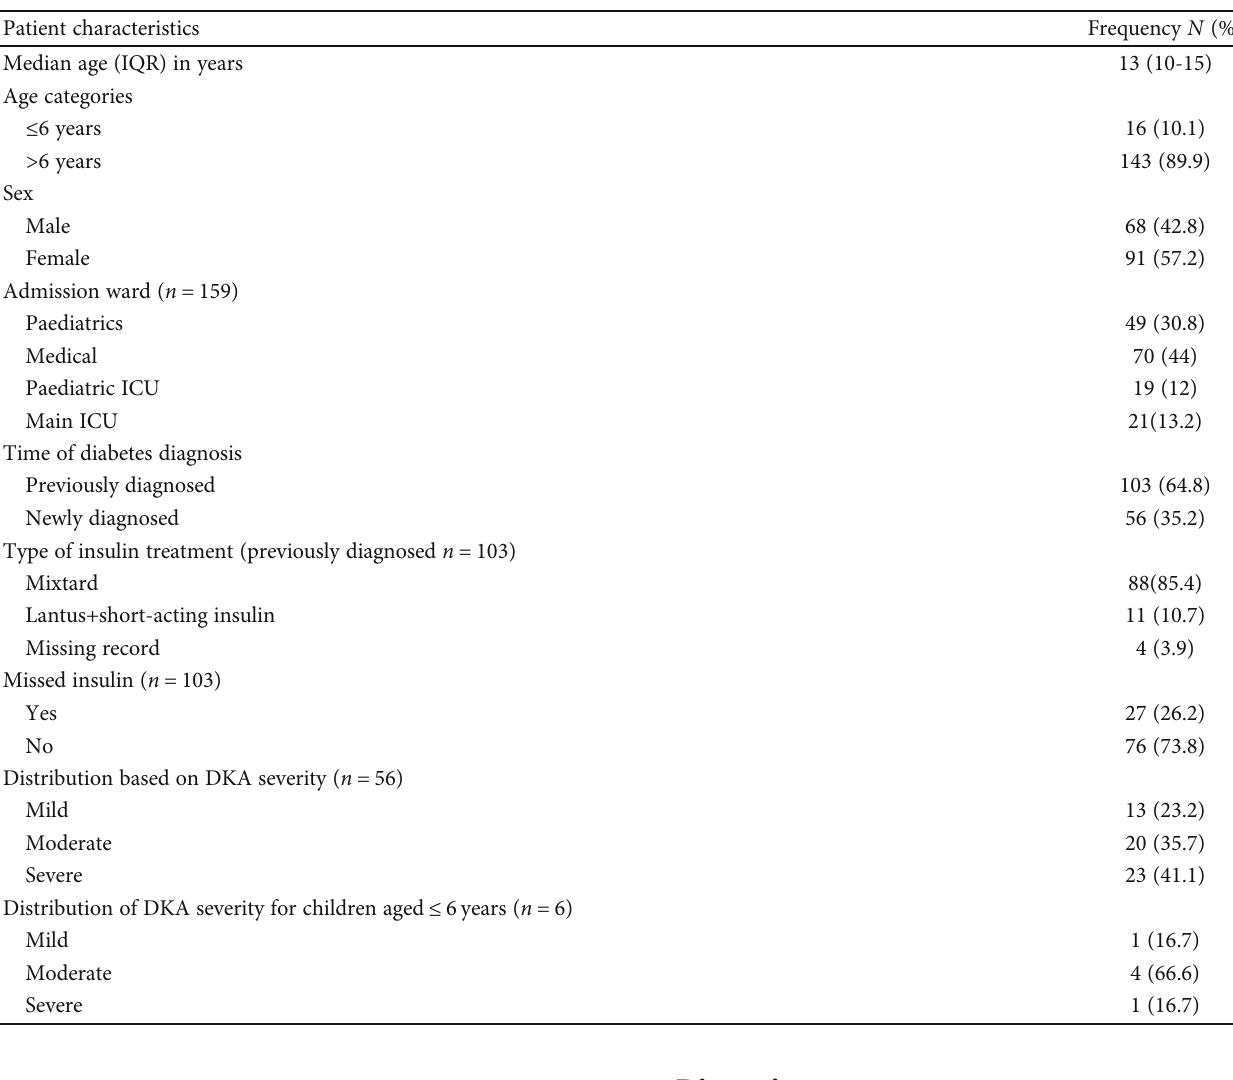
Table 1: Baseline characteristics of children admitted with DKA.